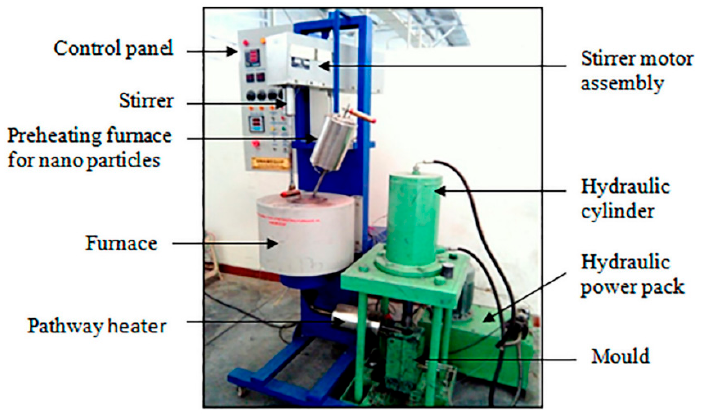
Figure 9. Squeeze casting setup [75].